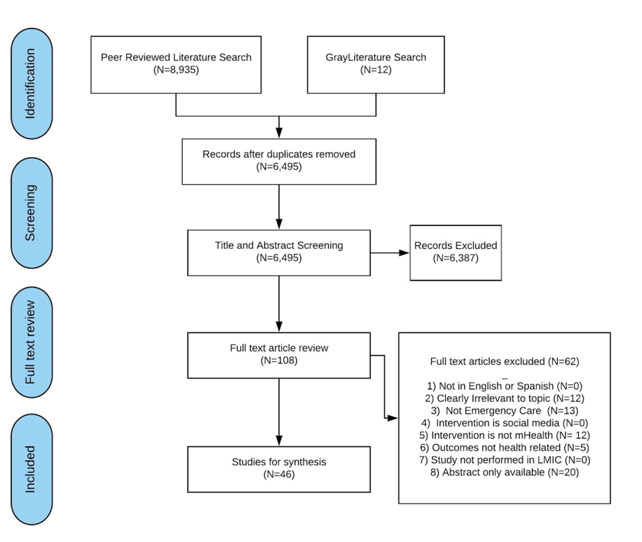
PRISMA flow diagram.